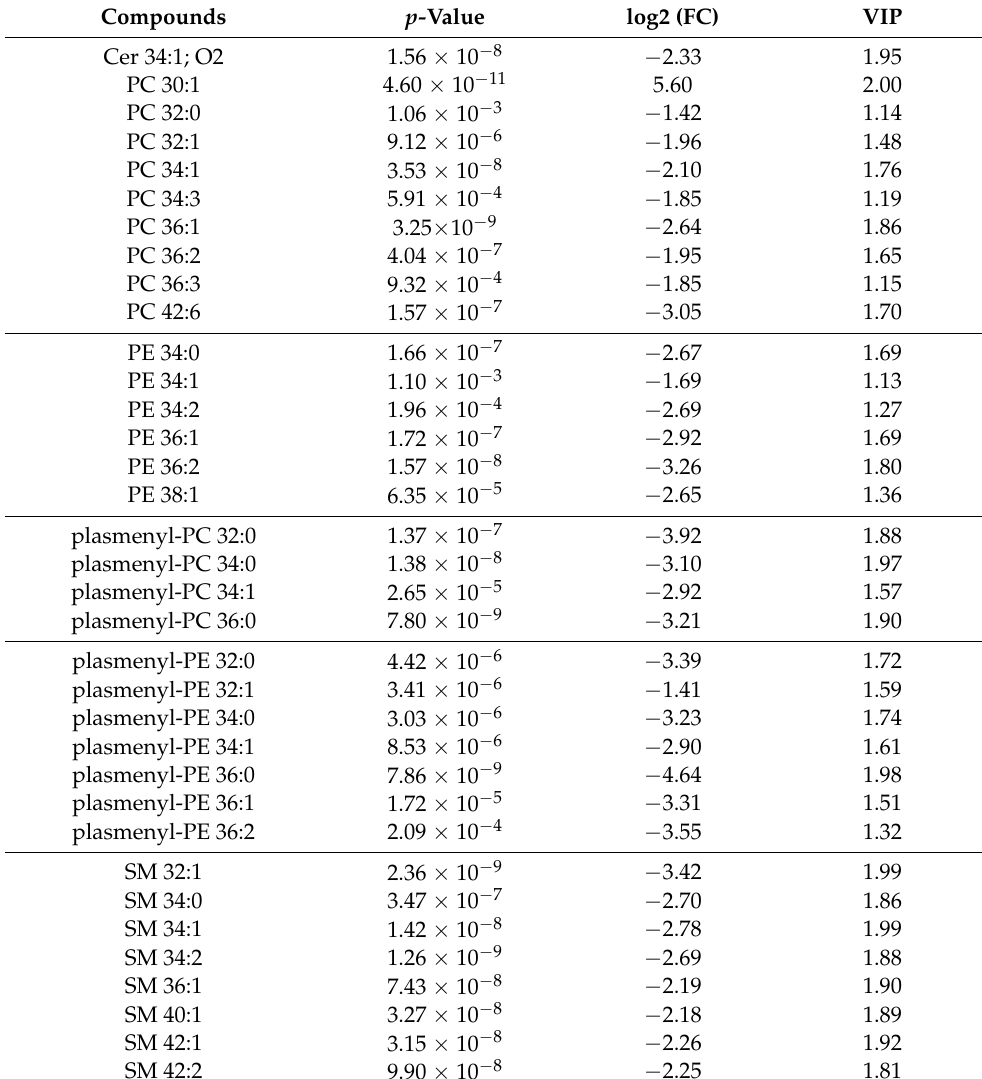
Table 1. Variable importance for projection value (VIP value), t -test, and fold change (FC = PTB/TB) of developed